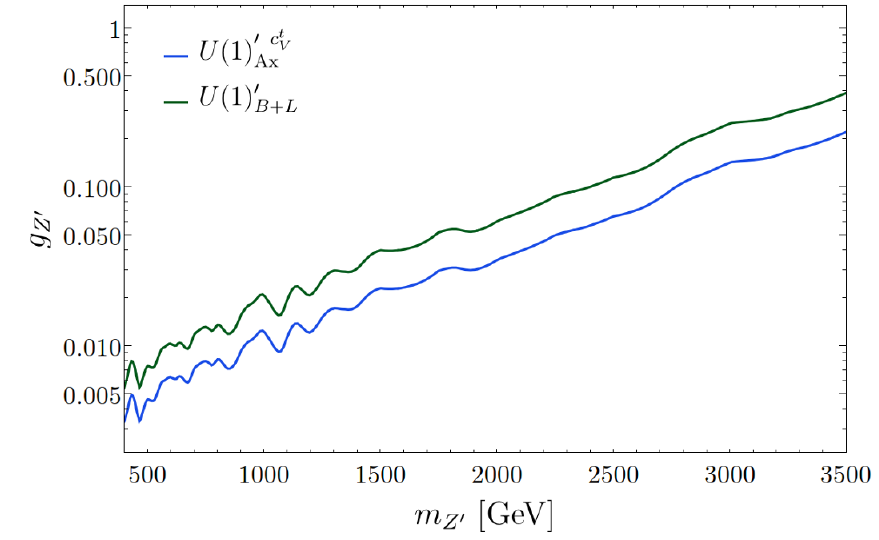
Figure 8 . Bounds from resonant dilepton searches on a Z 0 at LHC from the 8 + 13 TeV com- bined analysis [65], presented in the g Z 0 - m Z 0 plane for U(1) 0 c unconstrained).